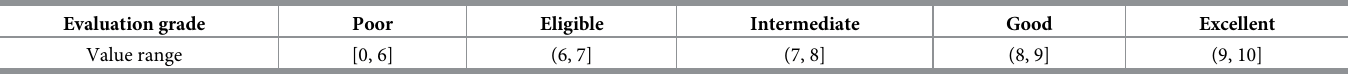
Table 9. The value range for each evaluation grade. Evaluation